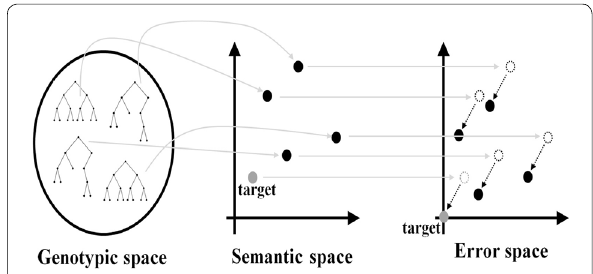
Fig. 2 A simple 2D vision of genotypic, semantic and error